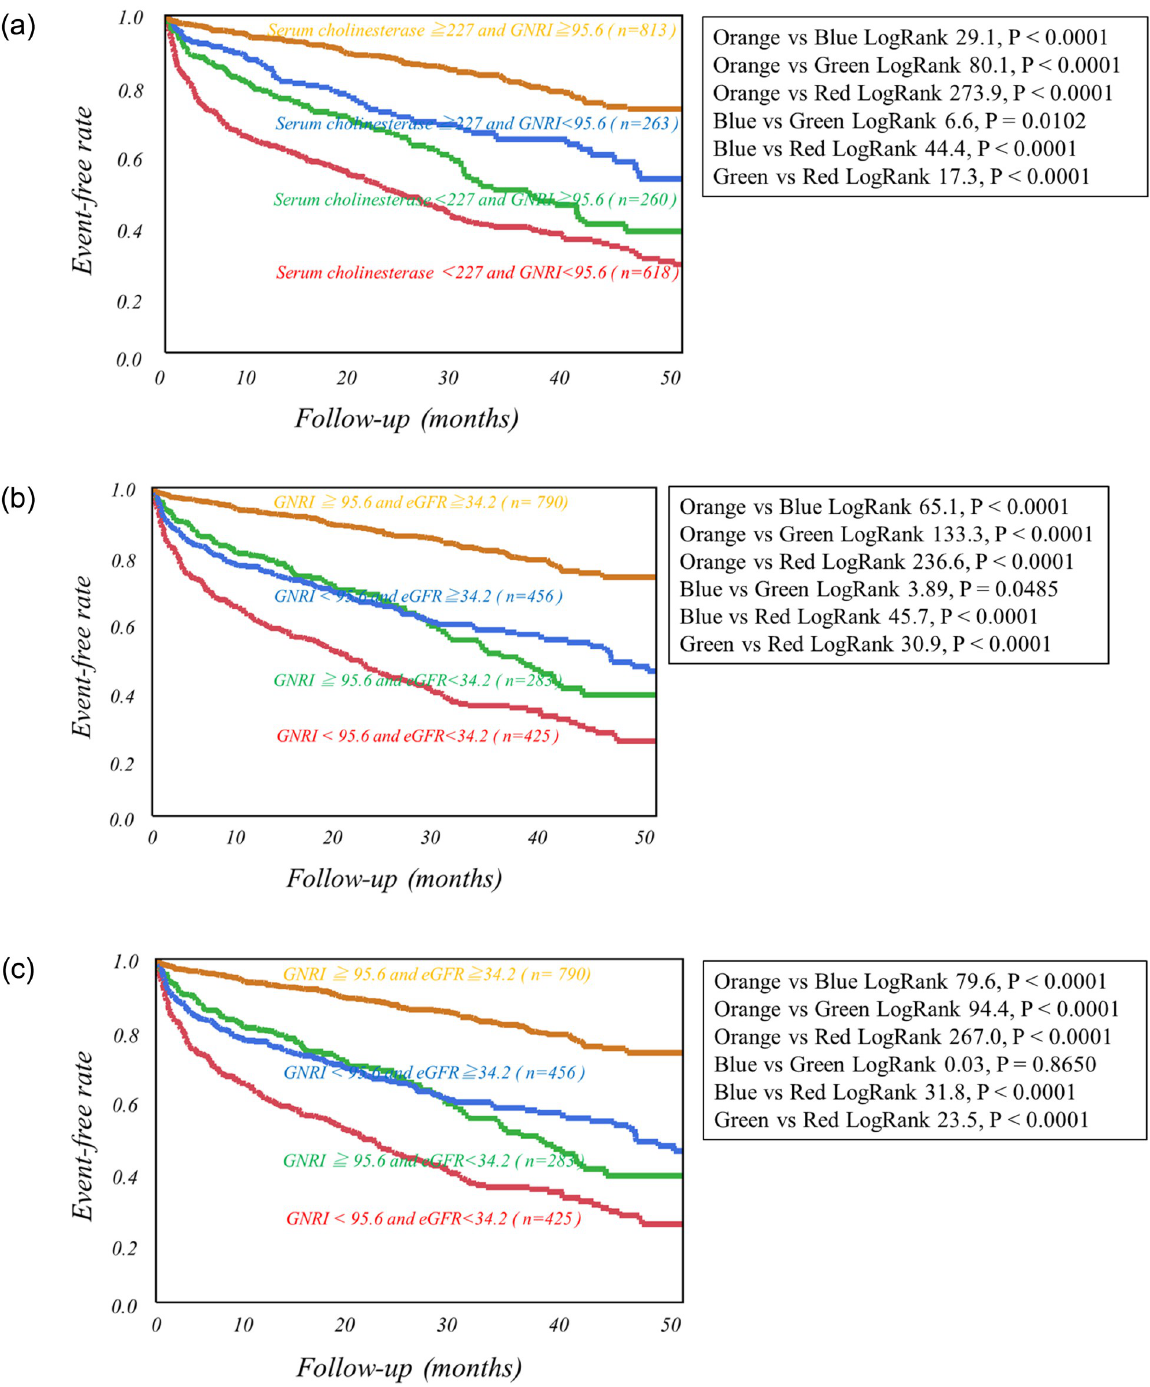
Fig 2. Kaplan-Meier event-free curves created by the combinations of two of the three prognostic variables including serum cholinesterase, Geriatric Nutritional Risk Index (GNRI) and estimated GFR. (a) Serum cholinesterase and Geriatric Nutritional Risk Index (b) Serum cholinesterase and estimated GFR (c) Geriatric Nutritional Risk Index and estimated GFR.